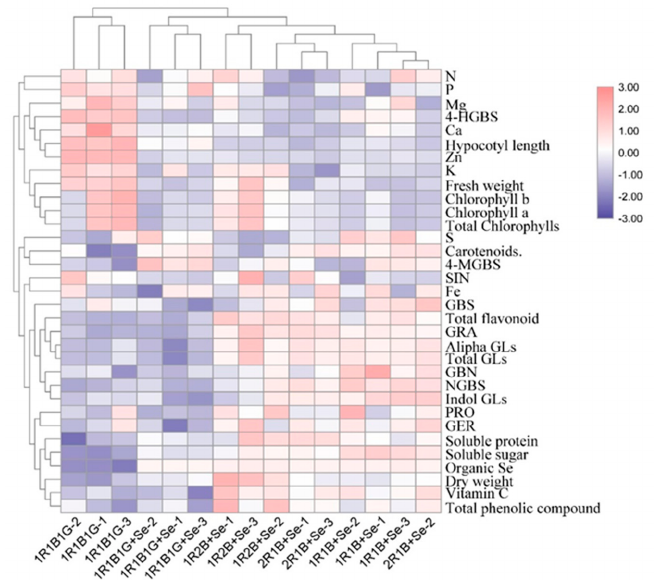
Figure 4. Cluster heat map analysis of broccoli sprouts grown under a combination of selenium and LED light quality treatments. Results are visualized using a false color scale, with blue indicating a decrease and pale red indicating an increase of the response parameters. Molecules 2020 , 25 , x